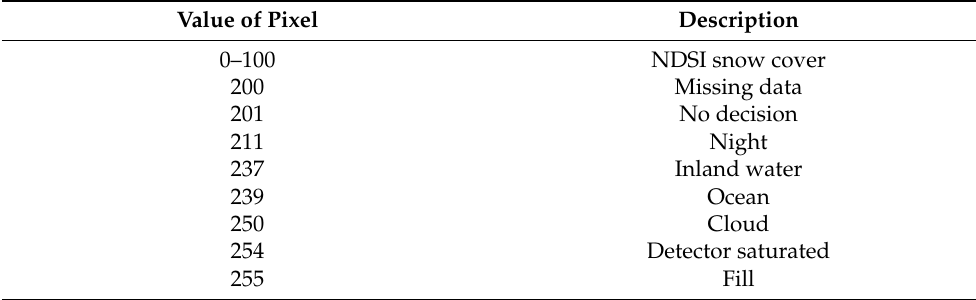
Table 1. NDSI snow cover dataset